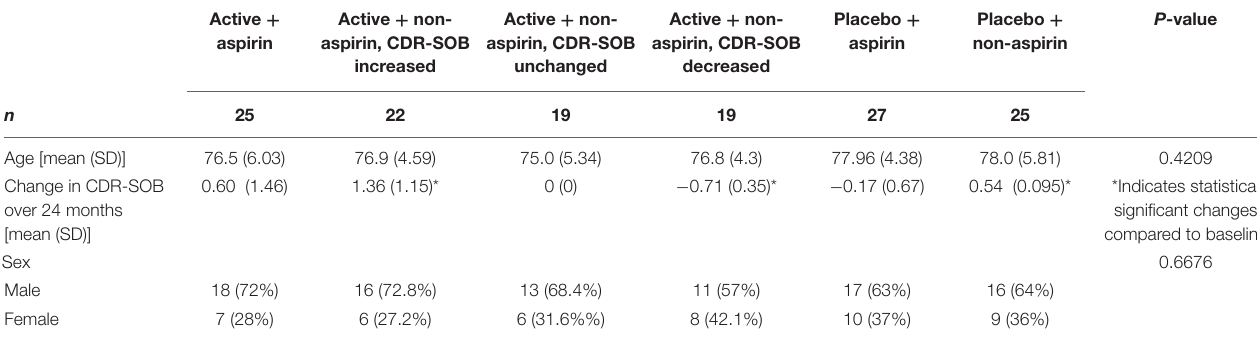
TABLE 1 | Clinical cohort